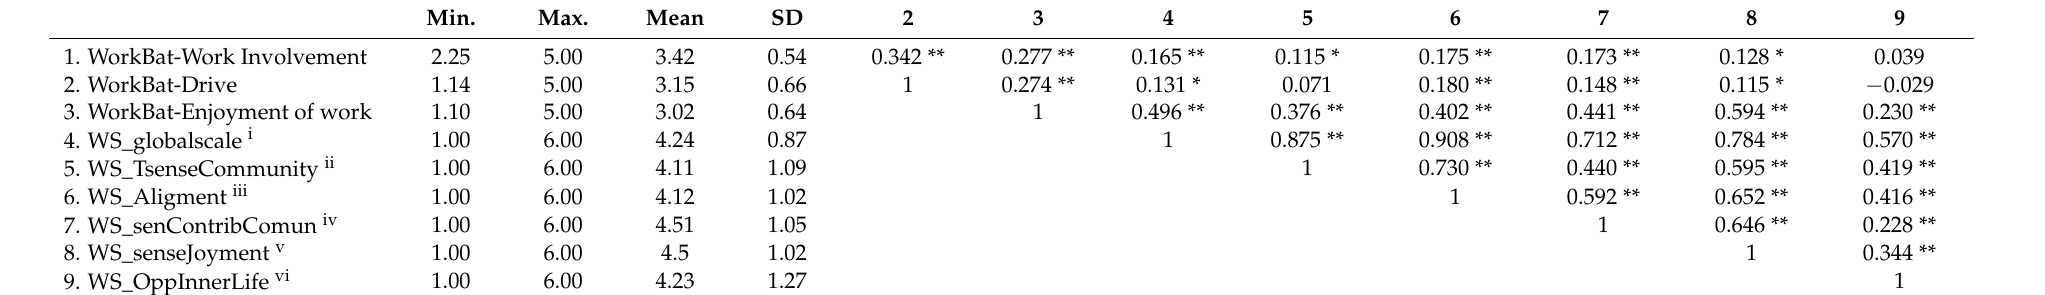
Table 2. Descriptive statistics (min, max, M, SD) and correlation